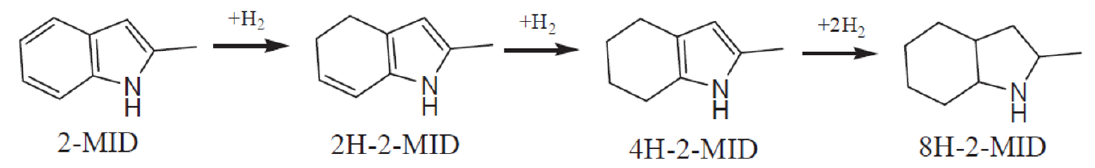
Figure 8. The schematic hydrogenation route from 2-MID to 8H-2-MID. Reprinted with permission from [89].